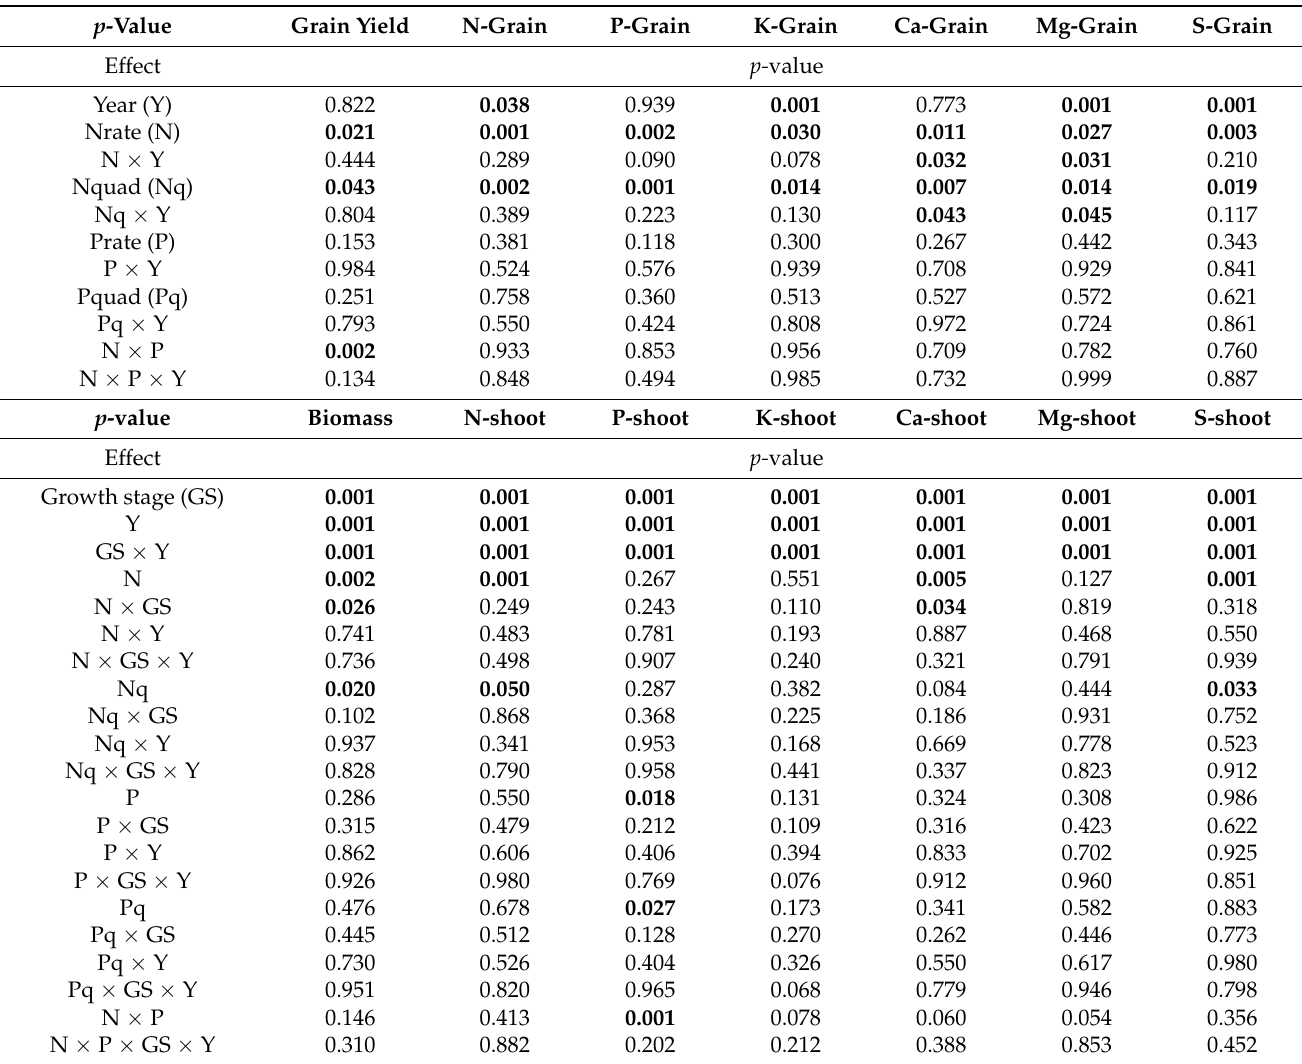
Table A1. Summary of statistical analysis for grain yield; grain N, P, K, Ca, Mg, and S accumulation; biomass accumulation; biomass N, P, K, Ca, Mg, and S accumulation under removed residue management in 2013 and 2014 as a function of year, growth stage, and N and P 2 O 5 application